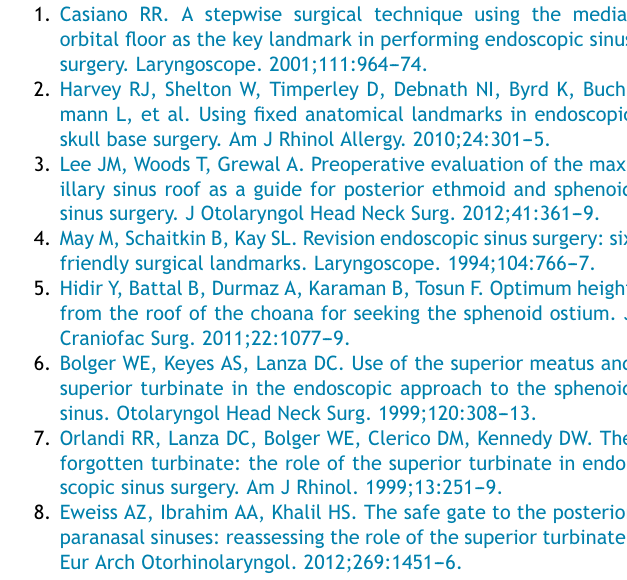
maxillary sinus was found to be approximately 70 mm from the base of the